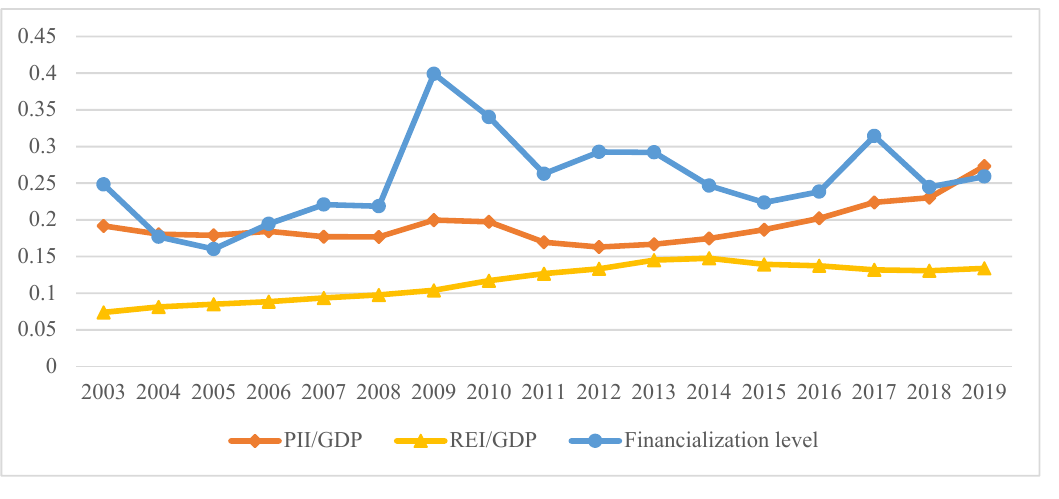
Figure 4. Public infrastructure investment, real estate investment and financialization level (=AFRE/GDP) in China from 2003 to 2019. Source: China’s National Statistical Bureau.